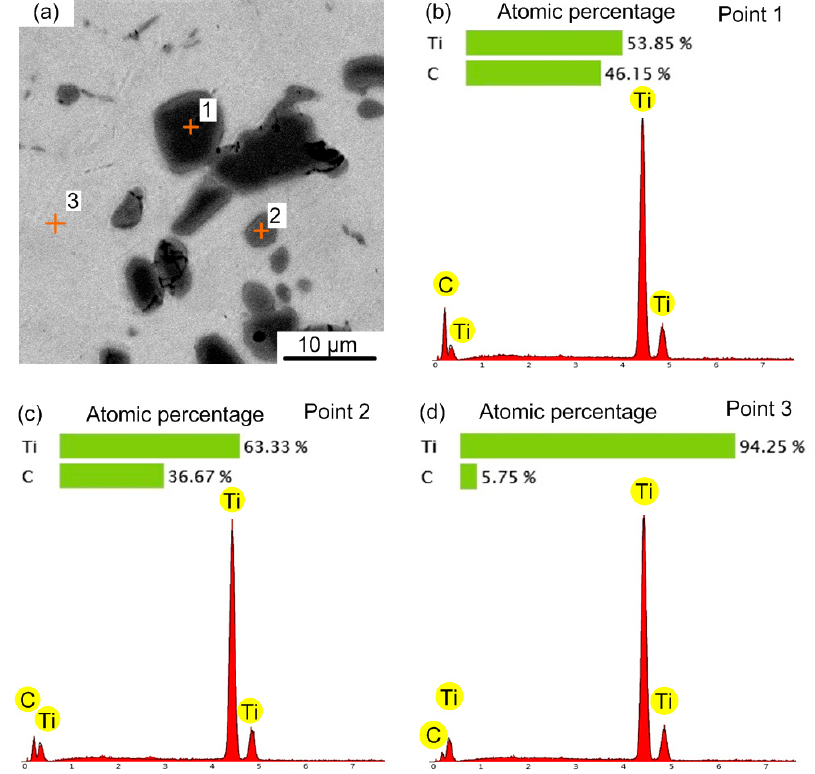
Figure 4. The EDS results of a laser DED fabricated TiC-TMC coating: ( a ) the microstructure morphology of the TiC-TMC coatings; ( b – d ) the element composistions of different